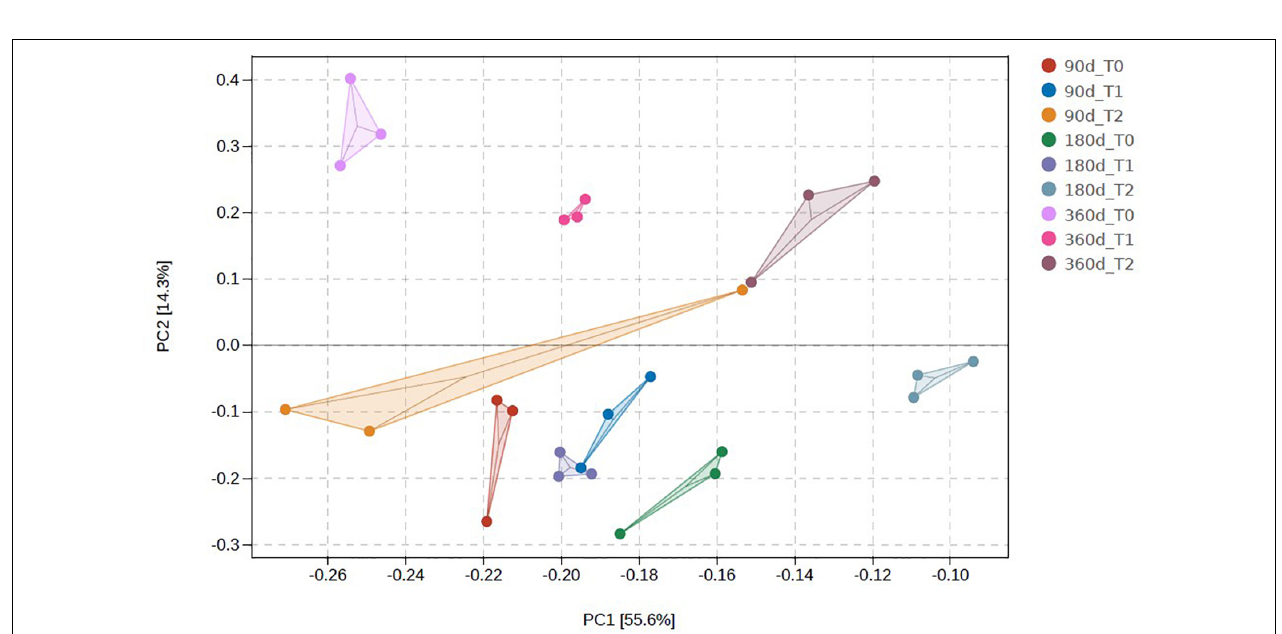
FIGURE 4 | Bacterial community composition and their hierarchical clustering in the tailing sand at the genus level. T0, iron tailing sand + soil; T1, iron tailing sand + soil + Pennisetum giganteum ; T2, iron tailing sand + soil + bio-matrix pot + Pennisetum giganteum ; 90 d, 180 d, and 360 d indicate the sampling time in days after the start of the experiment.